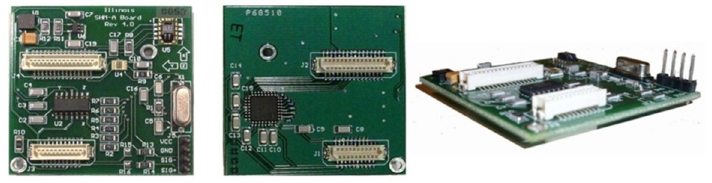
Figure 10. Illinois SHM Project: structural health monitoring-acceleration (also known as SHM-A) sensor board: top ( left ), bottom ( middle ), and perspective view ( right ) [78].